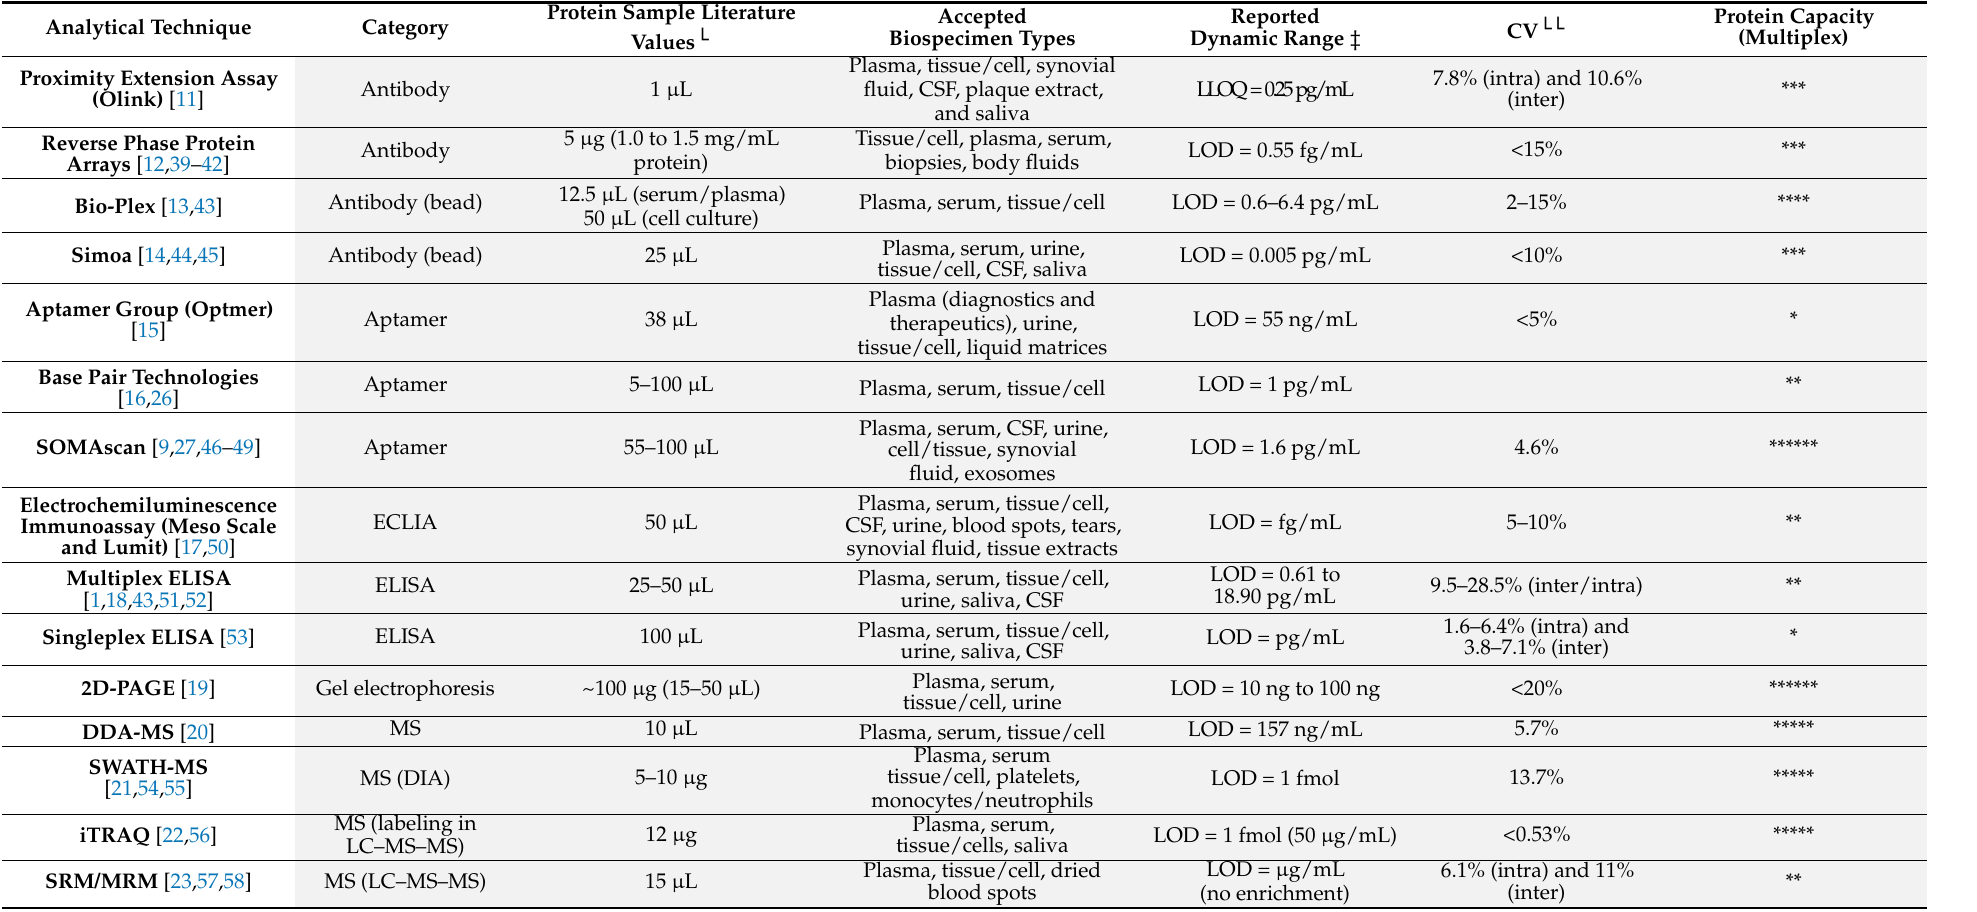
Table 1. Overview of Common Proteomic Platforms.